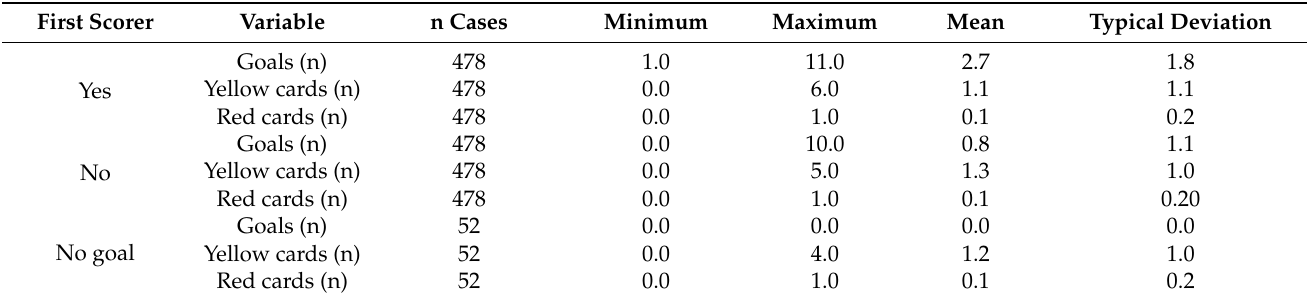
Table 2. Descriptive data of final number of goals and red/yellow cards by the first